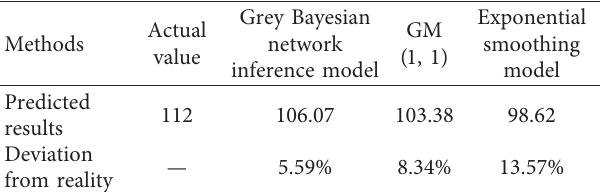
Table 6: Comparison of different prediction models in 2019 (unit: 10,000